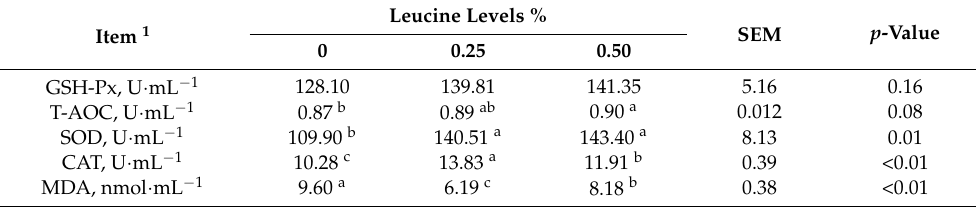
Table 7. Effects of different levels of leucine on serum antioxidant enzyme activities of finishing pigs.